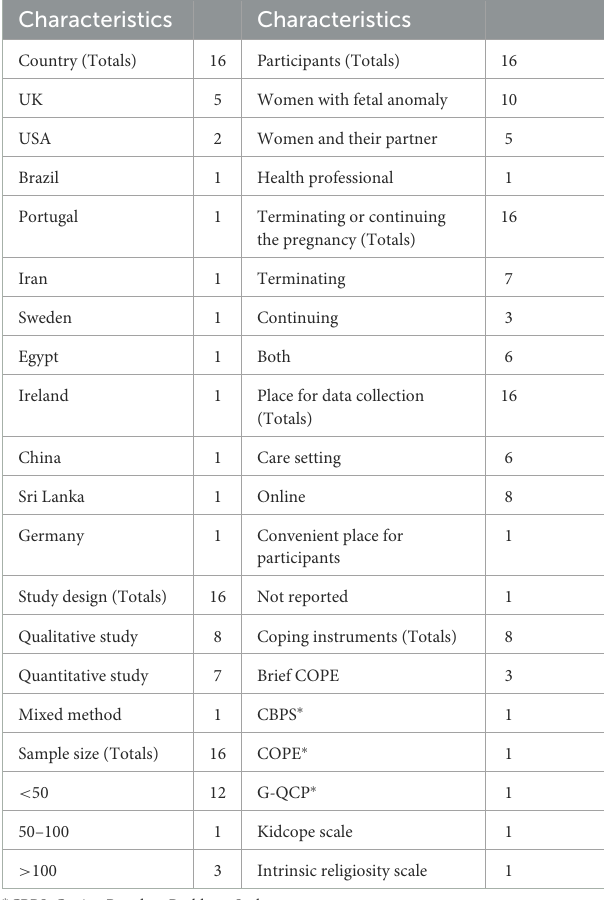
TABLE 3 Characteristics of included studies ( n =